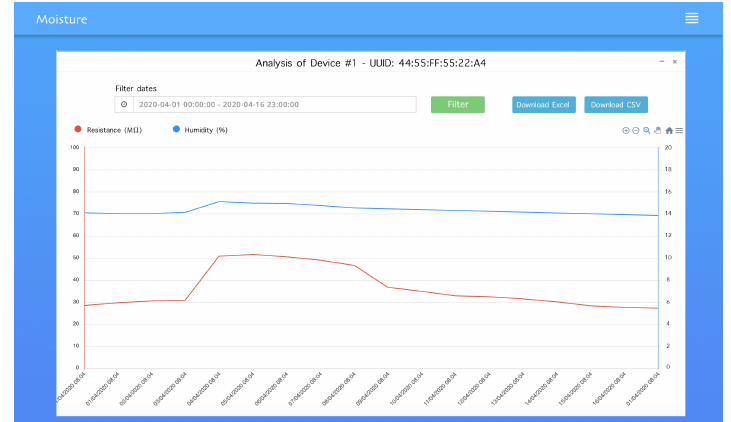
Figure 14. Web application device dashboard page showing the chart of moisture and resistance in function of time, the user can filter data by date and download it as Excel or CSV